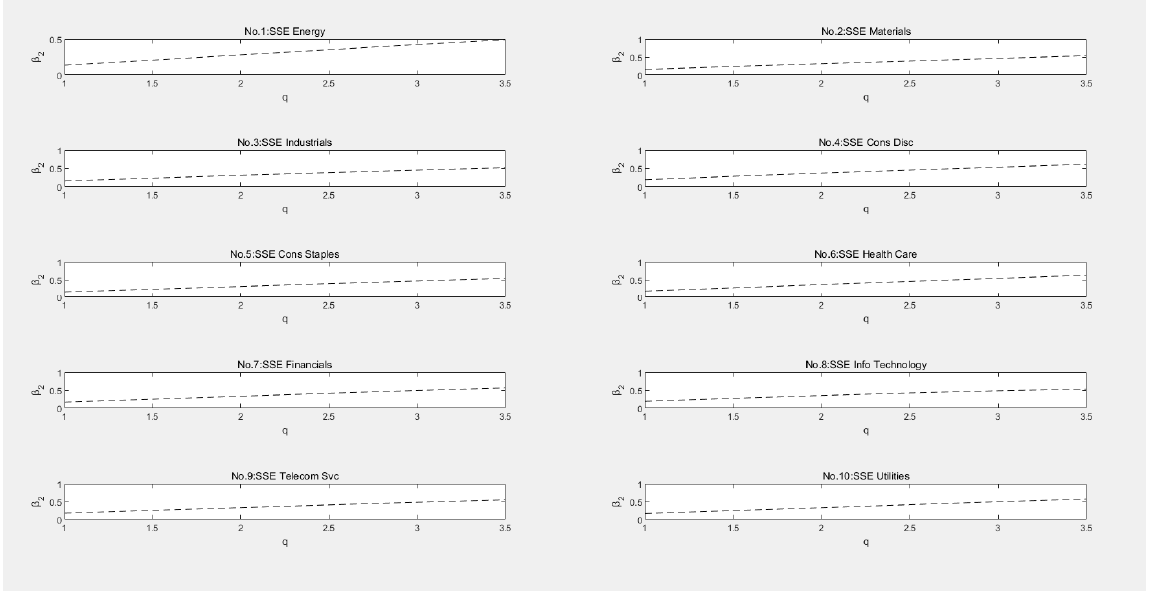
Figure 5. β 2 against q based on the logarithm of truncated spot volatility for the 10 industrial indices.